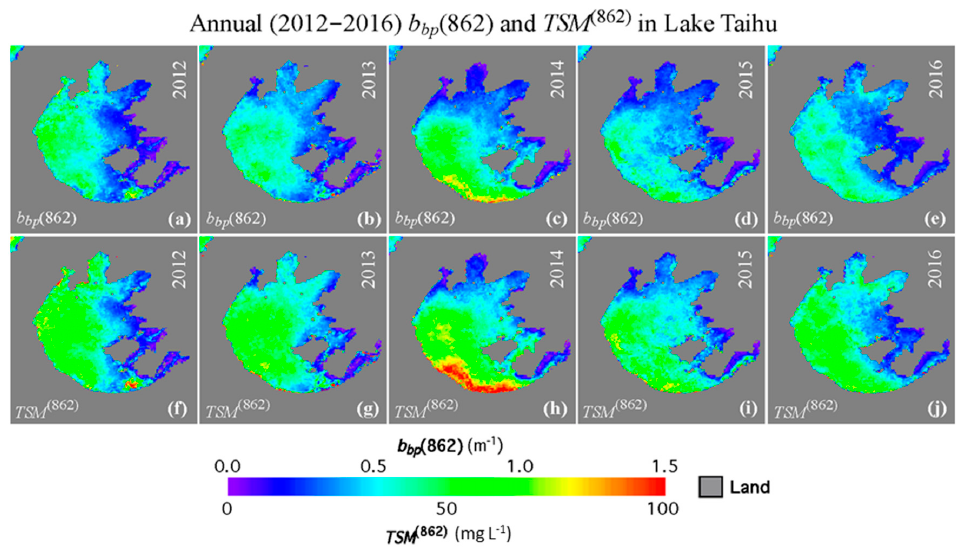
Figure 7. VIIRS-derived yearly composite images of b bp (862) ( a – e ) and TSM (862) ( f – j ) in the corresponding years of 2012–2016.